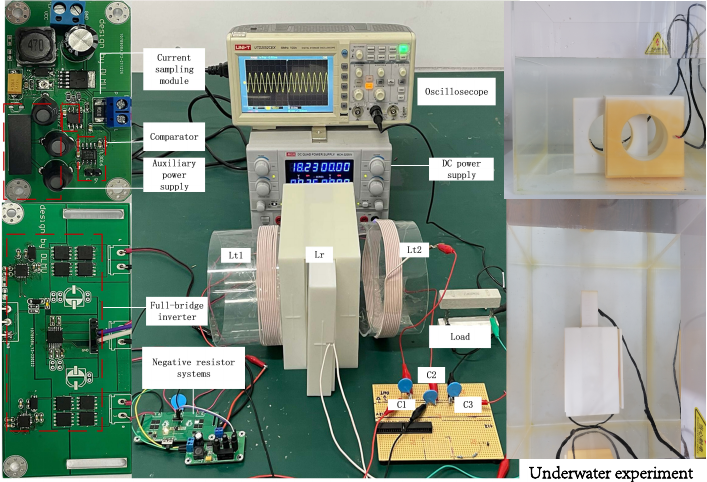
Figure 13. The experimental prototype of the proposed DTCWPT system based on